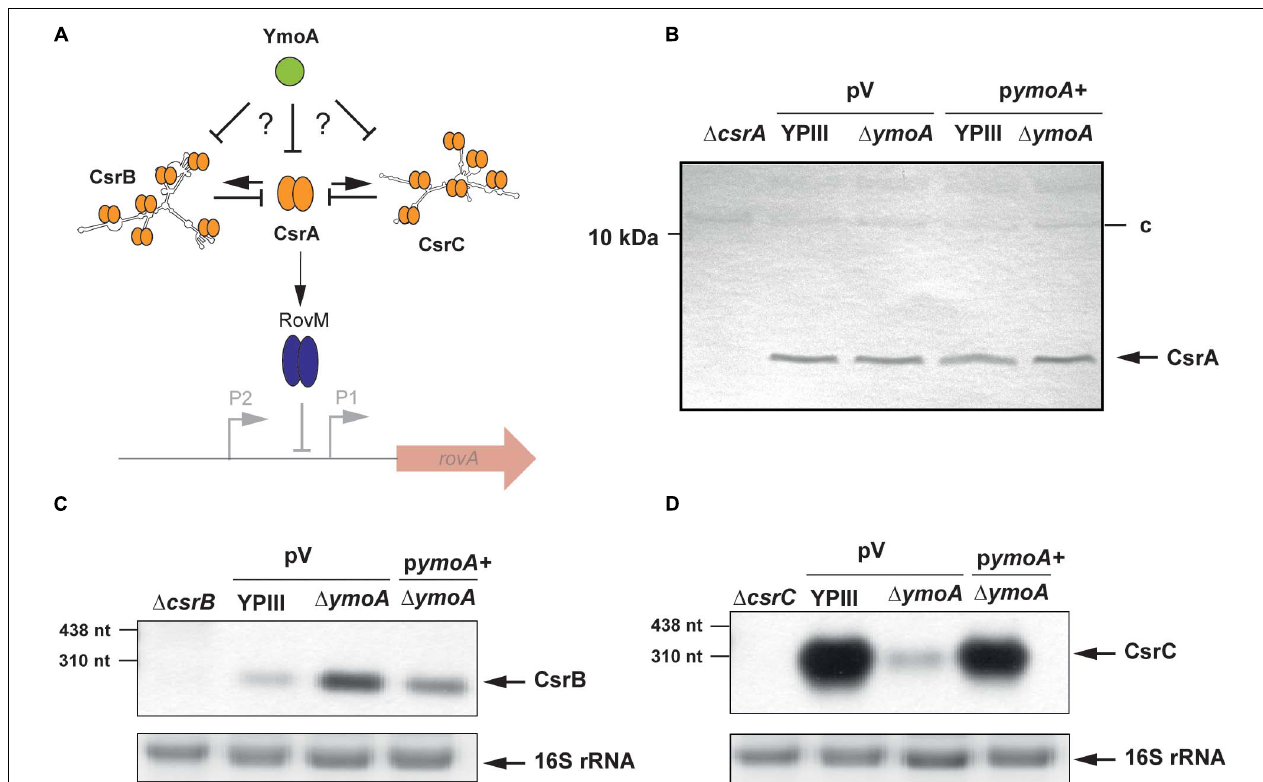
FIGURE 3 | Influence of YmoA on the synthesis of CsrA and the Csr-type RNAs of Y. pseudotuberculosis. (A) Illustration of potential YmoA influence on RovM synthesis via the CsrABC system. (B) Whole-cell extracts from overnight cultures of Y. pseudotuberculosis wild-type and mutant strain YP50 ( (cid:49) ymoA ) transformed with pACYC184 (V) or pAKH71 ( ymoA + ) grown at 25 ◦ C were prepared and analyzed by Western blotting with as a polyclonal antibody directed against CsrA YP50 ( (cid:49) ymoA ). YP53 ( (cid:49) csrA ) was used a negative control, and an unspecifically detected protein (c) served as loading control. (C,D) Total RNA of Y. pseudotuberculosis YPIII and YP50 ( (cid:49) ymoA ) carrying the empty vector pAKH85 (V) and YP50 pAKH71 (p ymoA + ), YP51 ( (cid:49) csrB ) and YP48 ( (cid:49) csrC ) was prepared, separated on agarose gels and a CsrB- or CsrC-specific probe was used to detect CsrB (C) or CsrC (D) by Northern blotting. The 16S rRNAs are shown as RNA loading control. Used RNA marker is indicated on the